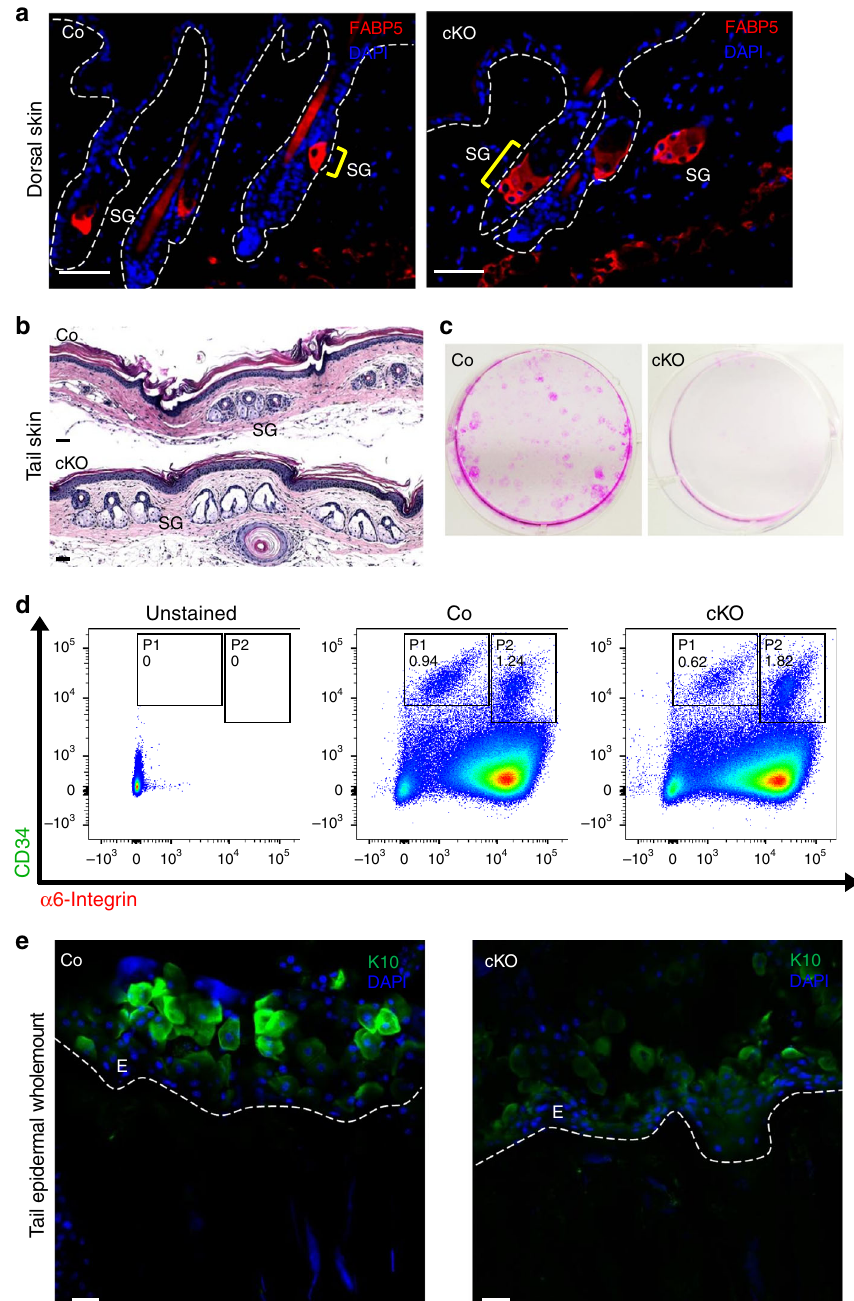
Fig. 2 JunB cKOs display impaired skin homeostasis. a Representative photomicrographs with immunostaining of FABP5 (red), indicative of sebaceous glands, in dorsal back skin from wild type and JunB cKO mice. Nuclei stained with DAPI in blue. Scale bars, 50 µ m. b Histology of tail skin from wild type and JunB cKO mice. Scale bars, 50 µ m. c Representative photo of colony-forming unit assay from FACS puri fi ed HFSCs (CD34 + ve α 6Itg Hi ) from wild type and JunB cKO mice back skin that were cultured in vitro for 2 weeks and then stained with Rhodamine B and Nile blue. n = 3 mice per genotype. d FACS analyses from second telogen phase displaying an increased ratio of P2 to P1 hair follicle stem cells (CD34 + ve α 6Itg Hi /CD34 + ve α 6Itg Low ) in unperturbed dorsal skin from 60 days old JunB cKO compared to wild type mice. e Confocal images of whole mount tail epidermis depict differentiated keratinocytes immunostained for the terminal differentiation marker k10 (green) in JunB cKO compared to wild type skin. Nuclei stained with DAPI in blue. Scale bars, 50 µ m. E, epidermis; SG, sebaceous JunB cKO skin (Fig. 3b and Supplementary Figure 4A). In addition, we detected impressively enlarged sebaceous glands at wound sites in JunB cKOs (Fig. 3b). These results indicate an essential so far unreported role of JunB in the regulation of (Fig. 3a, b). A hyperplastic thickened epidermis with a para- keratinocytes and their progenitors during skin repair and keratotic stratum corneum and enhanced in fl ammation was regeneration. observed in JunB cKOs as compared to wild type and uninjured